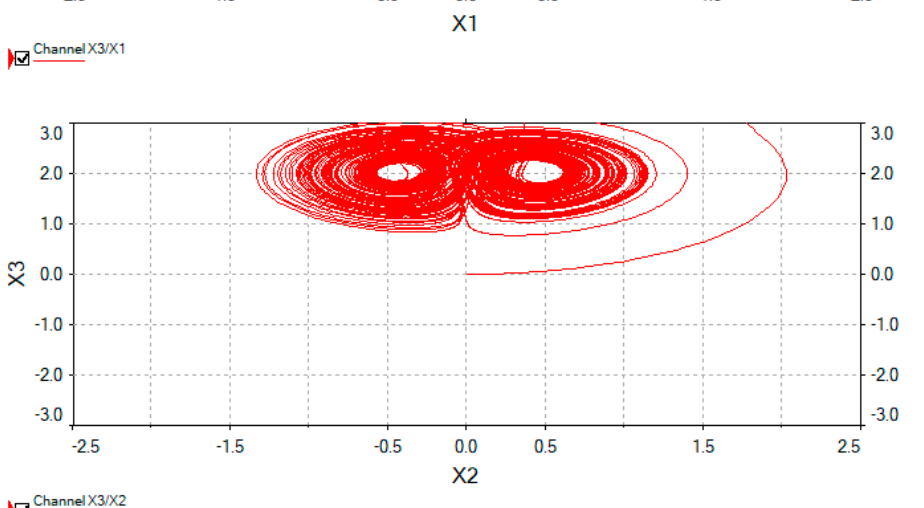
Figure 10. The phase portraits of circuit of the fractional-order chain system.